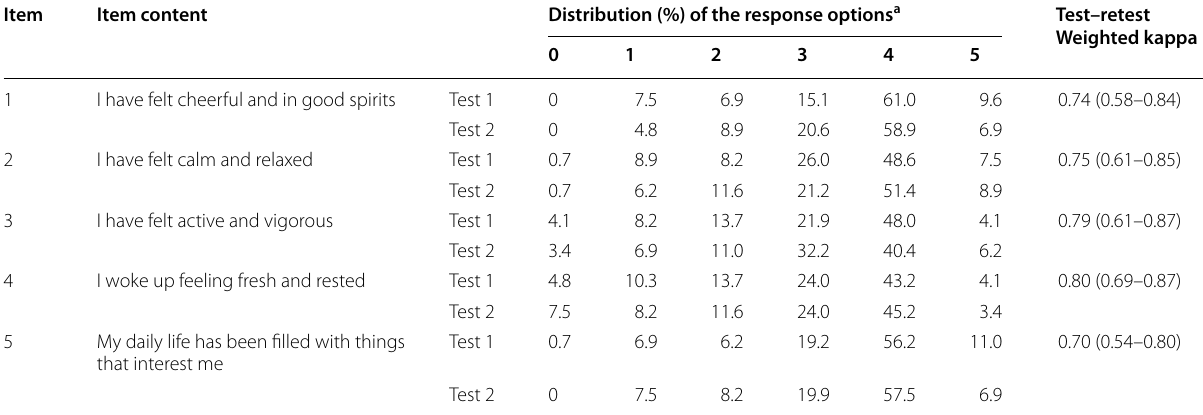
a 0 at no time, 1 =